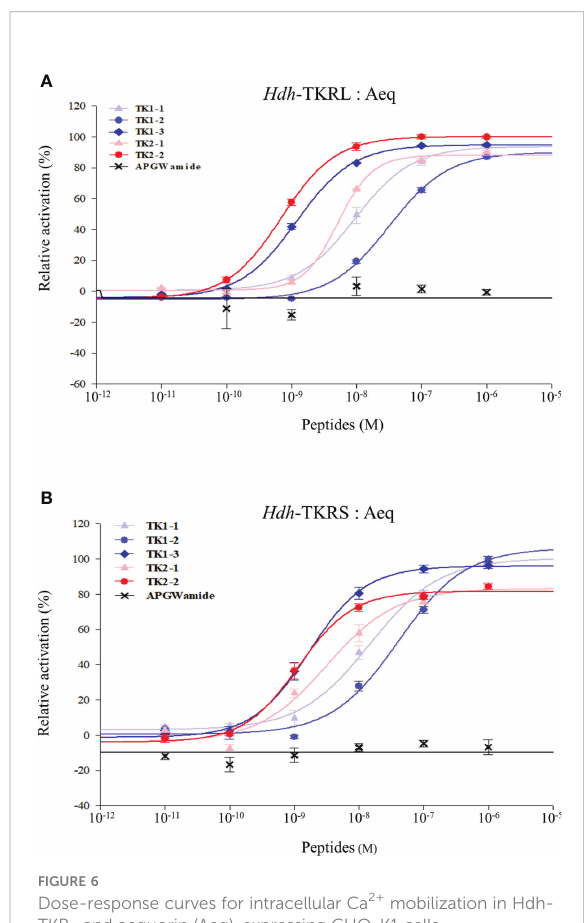
FIGURE 6 Dose-response curves for intracellular Ca 2+ mobilization in Hdh- TKR- and aequorin (Aeq)-expressing CHO-K1 cells. Luminescence was plotted relative to the maximal response achieved when TK peptides (10 − 6 M) were applied to the (A) Hdh-TKRL- or (B) Hdh-TKRS-transfected CHO-K1 cells. APGWamide was used as the negative control. Data represent the mean ± SEM (n = 3 or 4).